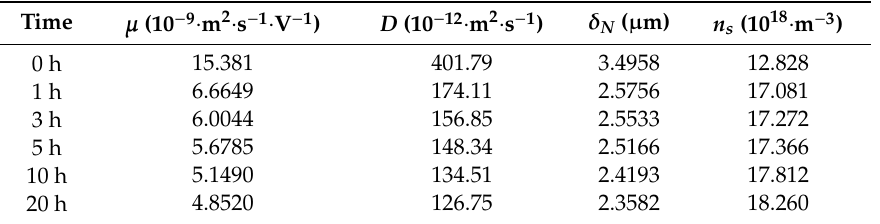
Table 2. Electrophysical parameters of the ion-doped LC cell obtained by using the measured impedance